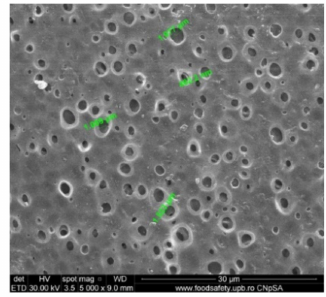
Figure 13. Illustration of the pore size on the posterior surface in the SEM image obtained for